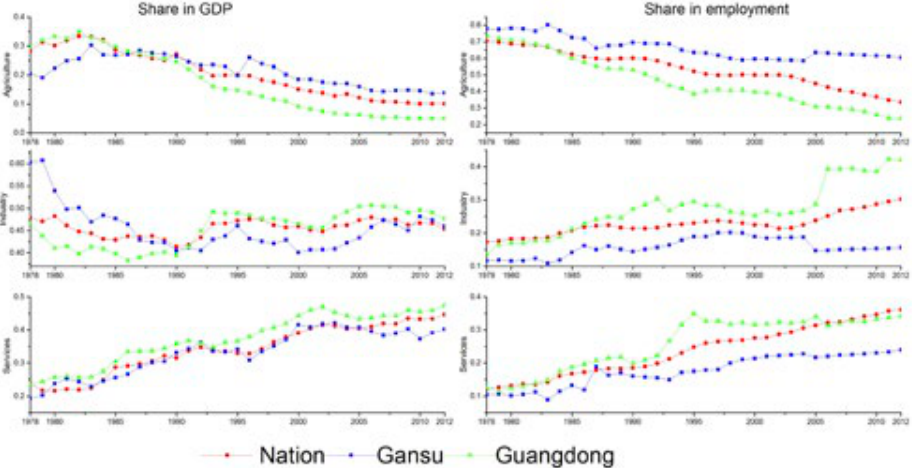
Figure 4. Sectoral shares in GDP and employment, Gansu province and national